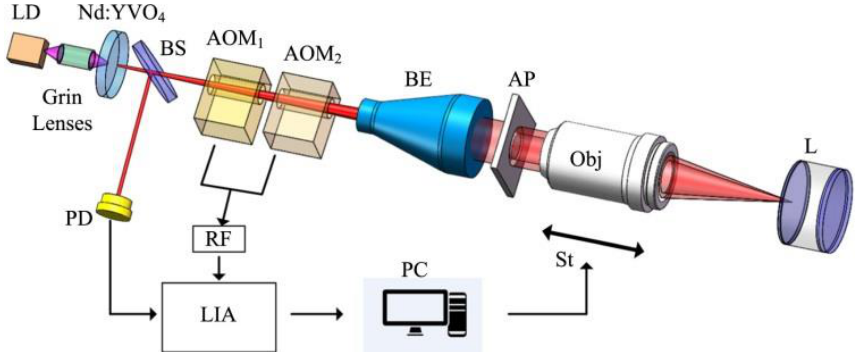
Figure 22. Schematic of the lens thickness measurement system. LD, laser diode; Grin Lenses, graded index lenses; BS, beam splitter; AOM 1 and AOM 2 , acousto-optic modulators; BE, beam expander; AP, annular pupil; Obj, objective lens; L, lenses; PD, photo detector; RF, reference signal generator; St, Stage; LIA, lock-in amplifier; PC, computer. (Figure reproduced from Ref. [93]). When the objective lens moves along the optical axis, and the focused beam passes through the surfaces of the lenses, the defocus response curve can be obtained at each interface. The peak of the curve corresponds exactly to the beam focusing on the surface of the lens, as shown in Figure 23.